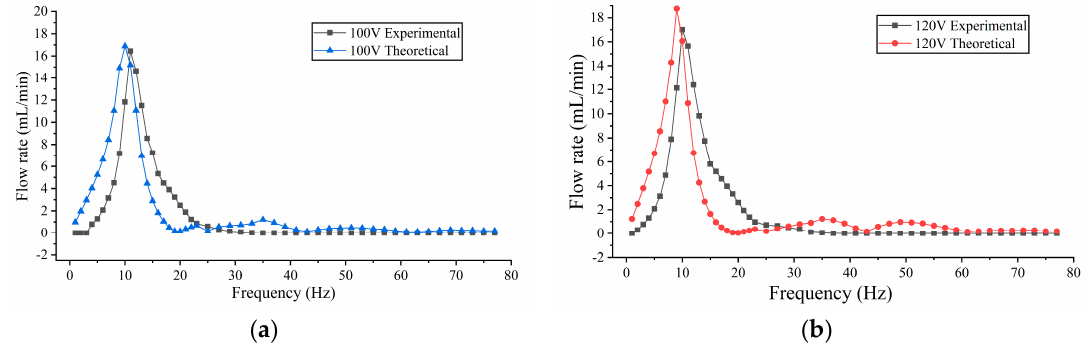
Figure 13. The theoretical and experimental flow rate at 100 and 120 V. ( a ) The flow rate at 100 V, ( b ) The flow rate at 120